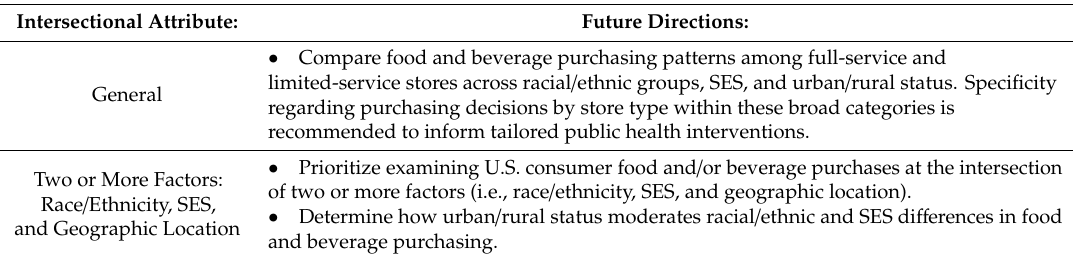
Recommendations for Future Directions in Assessing U.S. Consumer Food